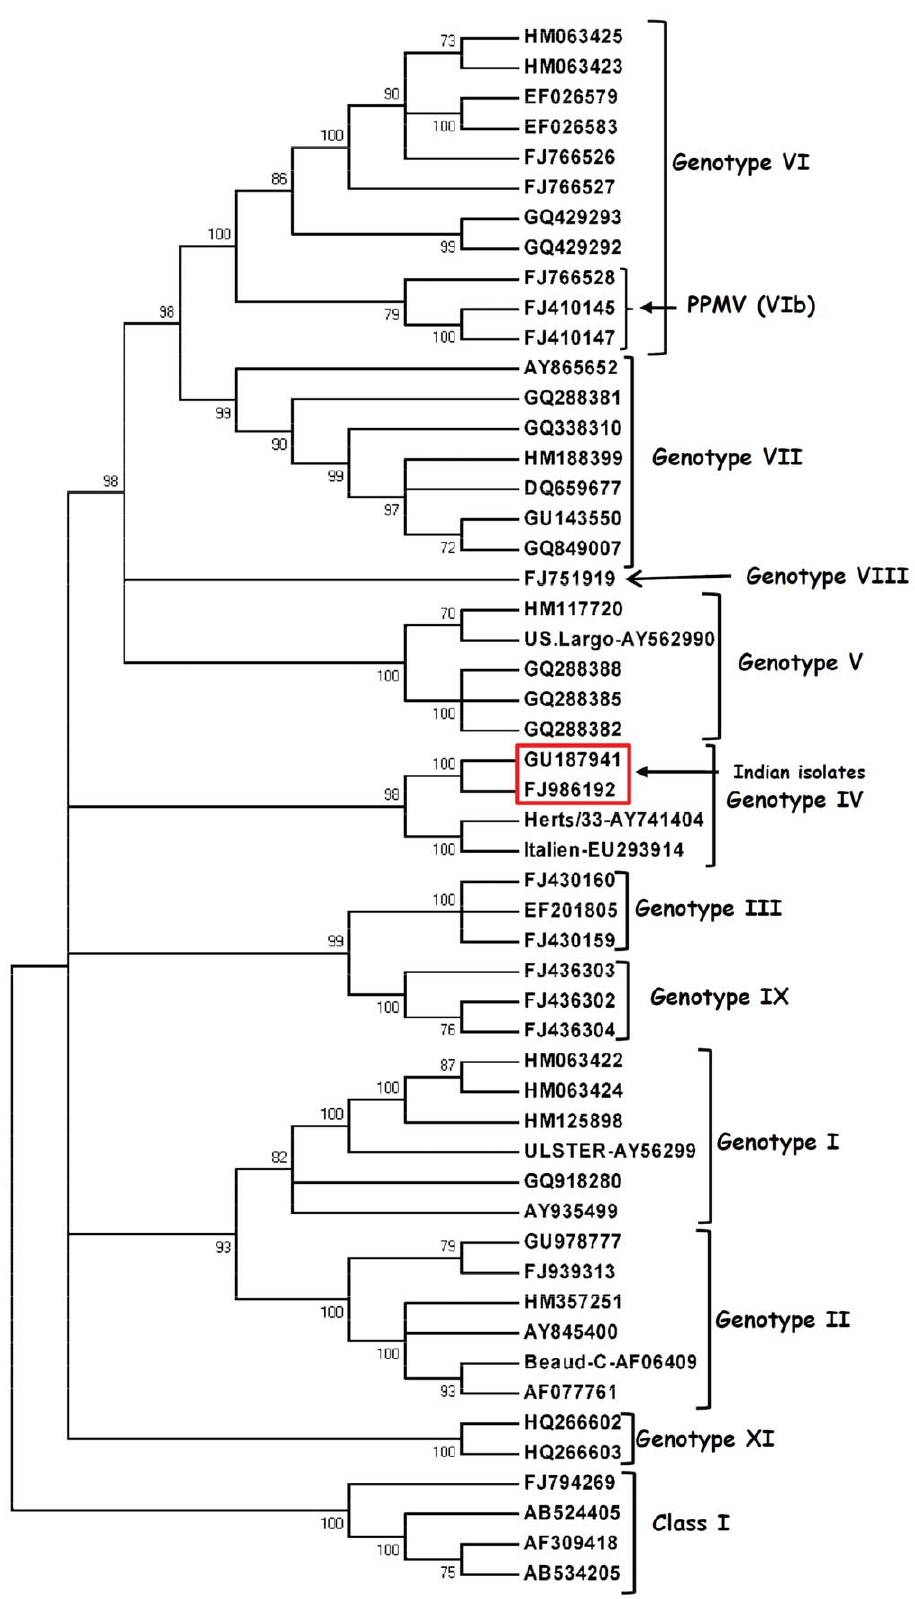
Figure 2. Phylogenetic analysis of the Matrix gene of the Pigeon isolate NDV-2K3/Pi/2000/IND (FJ986192) and Chicken isolate NDV- 2/Ch/1987/IND (GU187941) Tamil Nadu, India. The assembly of the matrix sequences was performed using the Clustal W algorithm in MEGA 5. Sequences of previously published matrix sequences of NDV strains representing different genotypes have been included from the GenBank with